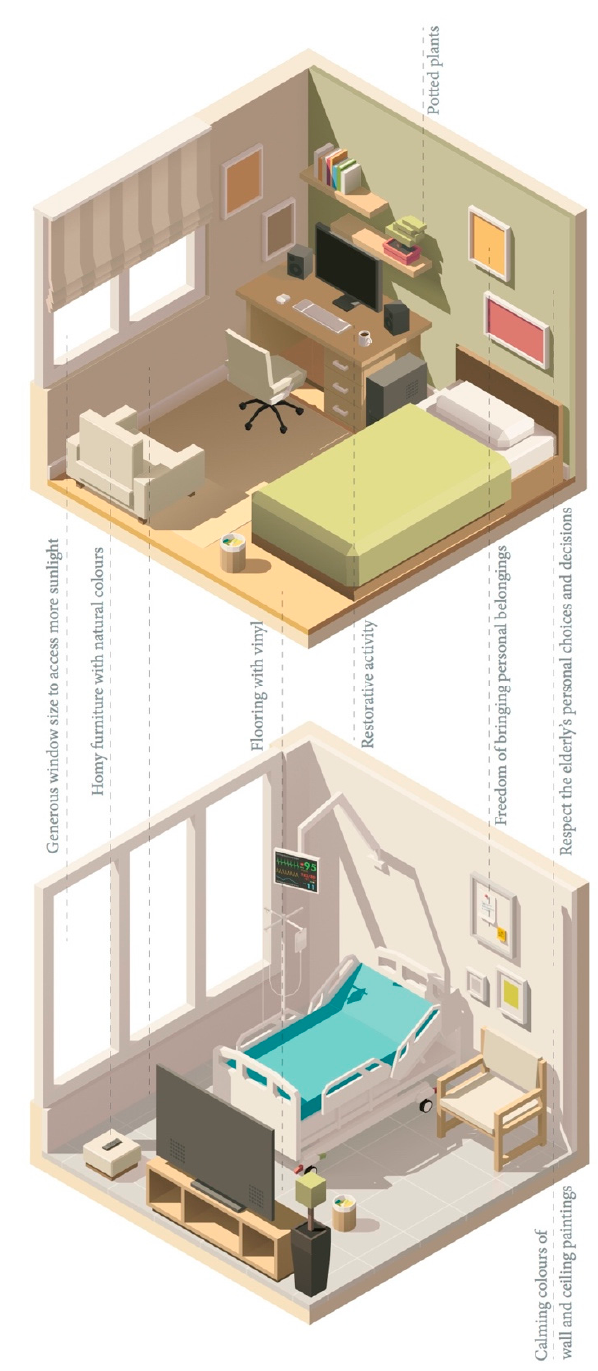
Figure 10. An existing low-care room ( top ) and a suggested high-care upgrade ( bottom ).